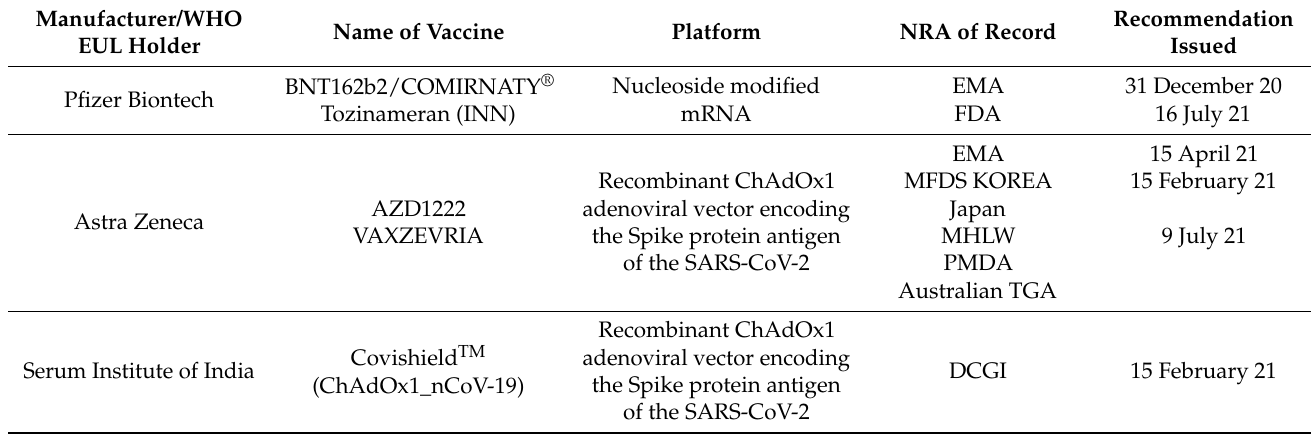
Table 2. COVID-19